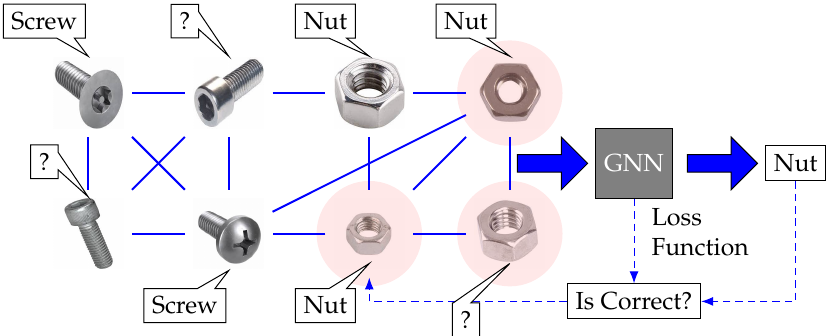
Figure 9. Illustration of graph-based SSL. The graph is constructed with the data samples as nodes and their numerical distances as edges, and the samples with correct marks are labeled ones. Sub- graphs (an example marked in red) are the GNN inputs and the outputs are the node labels (screw in the above graph).